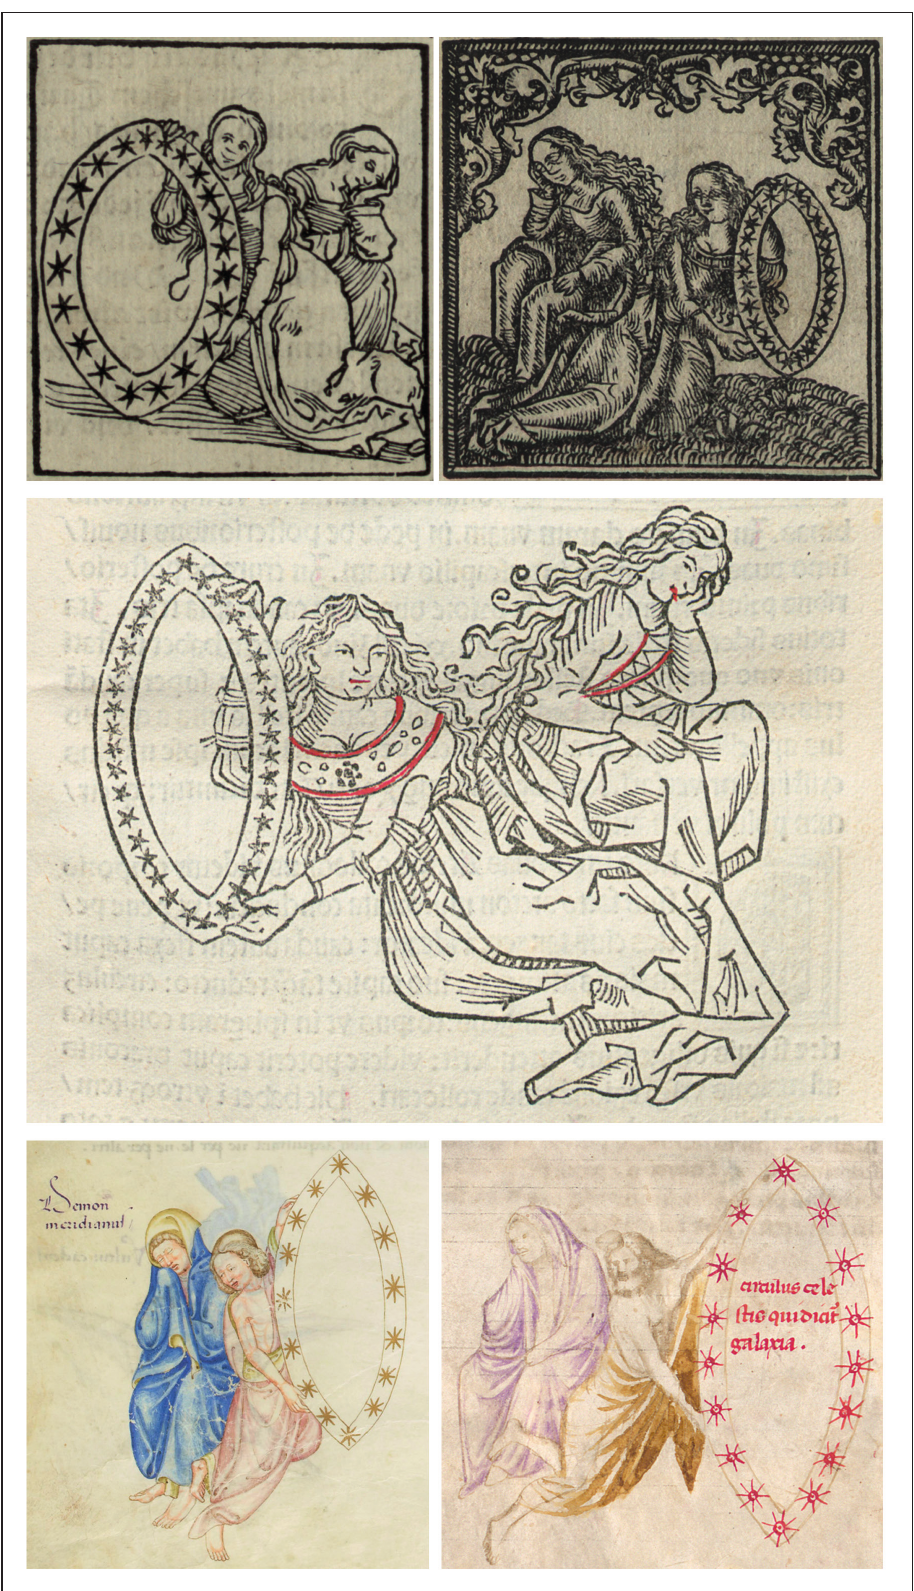
Figure 5: Top left : Woodcut from Regiomontanus, Ein newer Kalender , Strasbourg edition, 1537. Top right : Augsburg edition, 1539. Middle: Woodcut from Hyginus, De astronomia , Venice, 1482, fol. 23 r . © Bayrische Staatsbibliothek. Bottom left : Illumination from Fazio Degli Uberti, Il Dittamondo , Milan: 1447, (BNF Italien 81), fol. 177 v . © BNF. Bottom right : Illumination from Michael Scotus, Astrologia cum figuris (BSB Clm 10268), fol. 83 v . © Bayrische